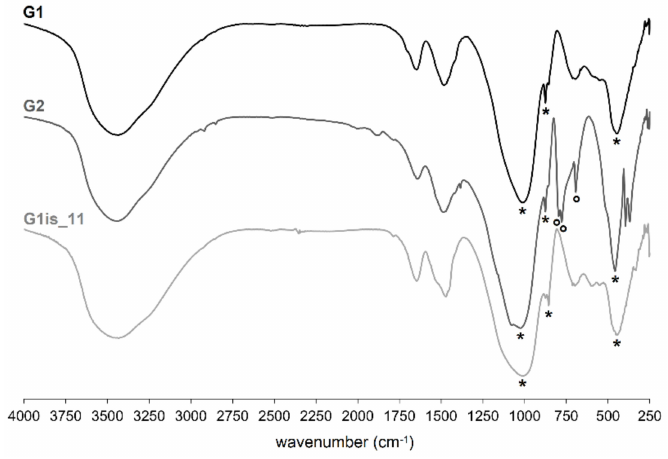
Figure 6. FTIR spectra of the G1, G2 matrices and of G1is_11 (* = signals relative to aluminosilicates; ◦ = signals due to quartz).